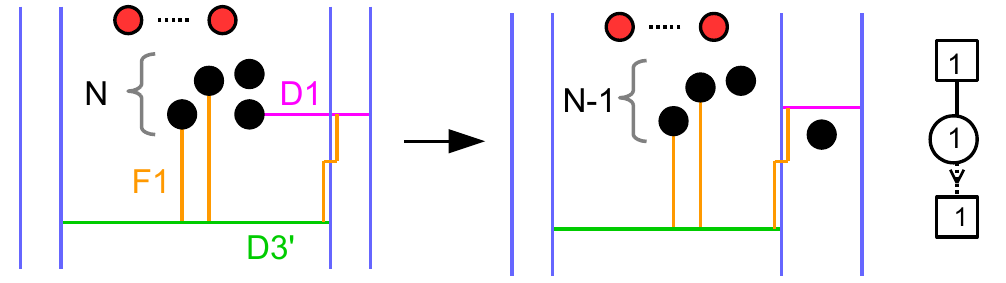
(cid:8) n i (here n = 3). The (cid:12)gure on 1